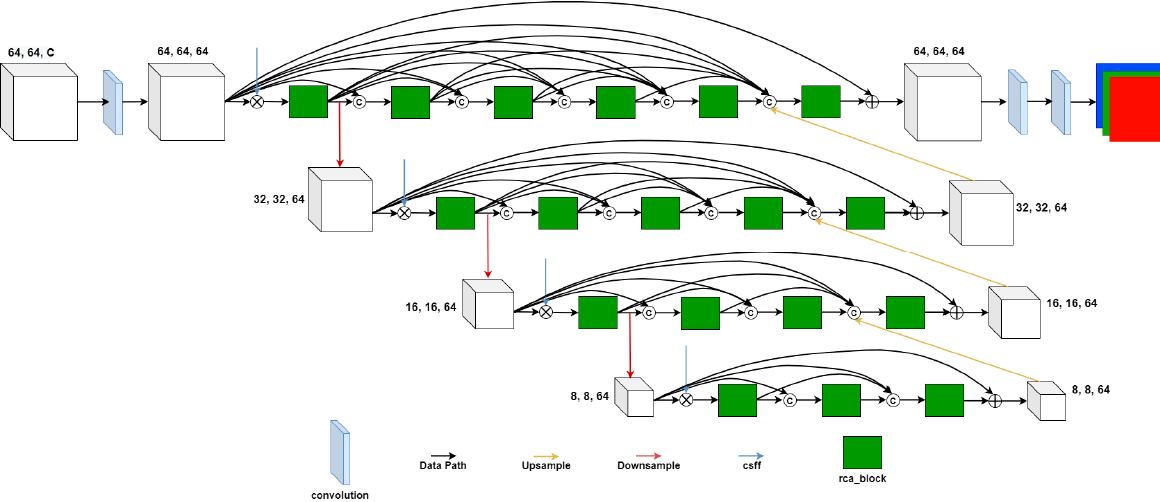
Figure 3. Architecture of proposed CS